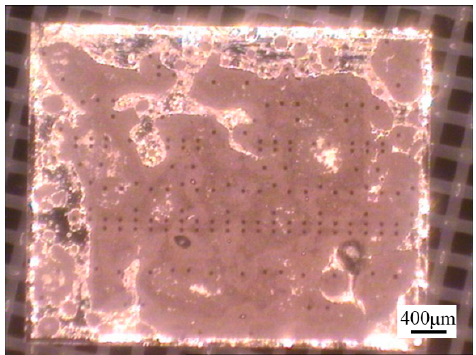
Figure 11. Void content of the Au/Ti/Au|Au-Sn eutectic joint: ( a ) 18.54% and ( b ) 2.36%.